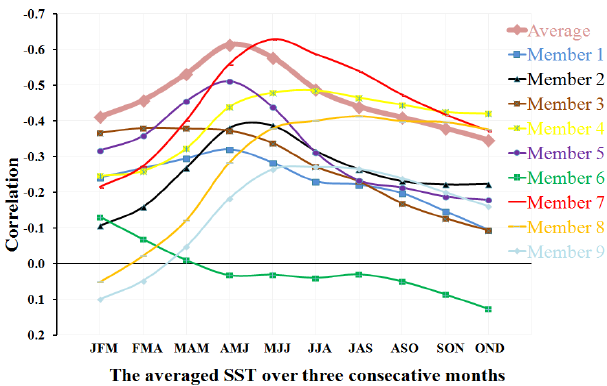
Figure 11. Correlation between rainfall anomalies over the Ethiopian Highlands (Reg-TB ensemble average and each individ- ual ensemble member) and SST anomalies over the Pacific Ocean in the Niño 3.4